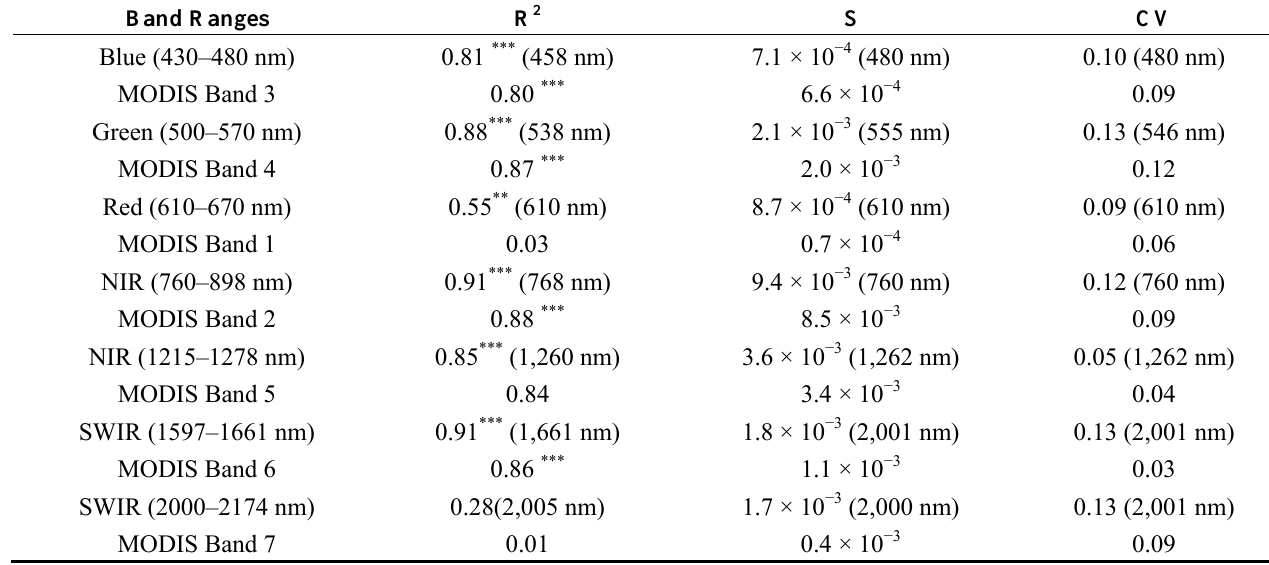
Table 1. Narrowband positions resulting in the best measures of cone density, based on maximum values of R 2 , slope (S), and coefficient of variation (CV), along with corresponding MODIS broadband for different spectral